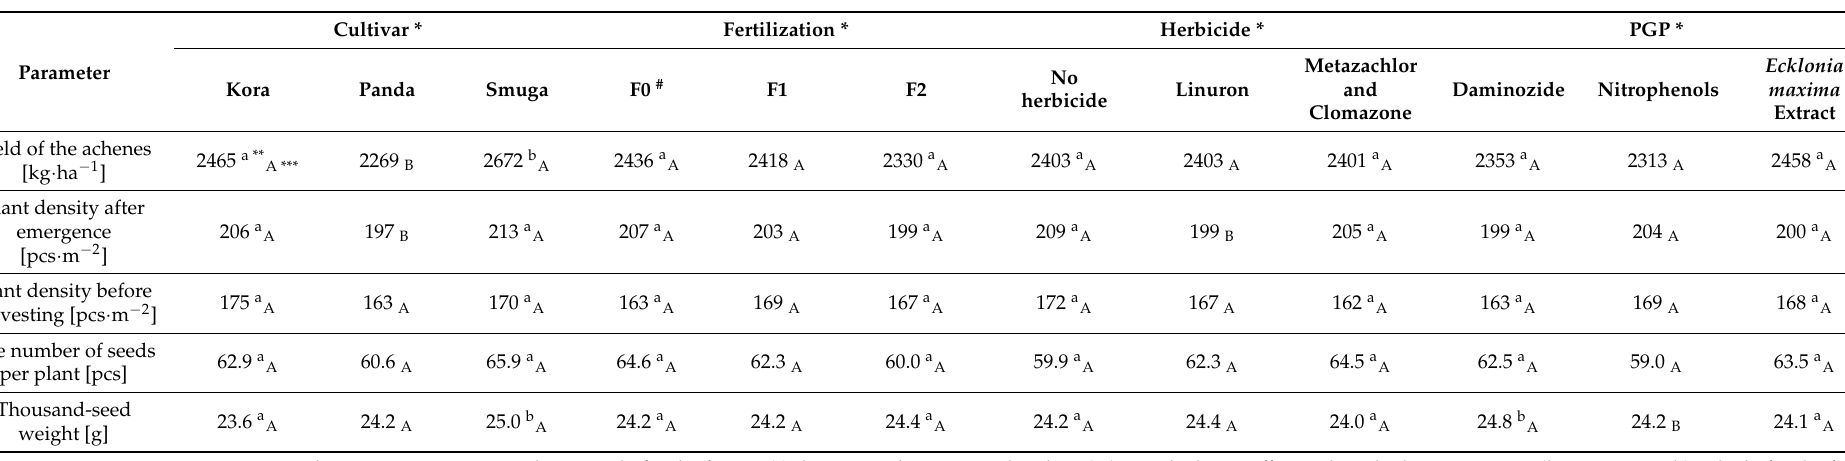
Table 4. Yield and yield components of common buckwheat under the influence of cultivar, calcium cyanamide fertilization, herbicide use, and PGP application. Cultivar * Fertilization * Herbicide * PGP * Parameter Kora Panda Smuga F0 # F2